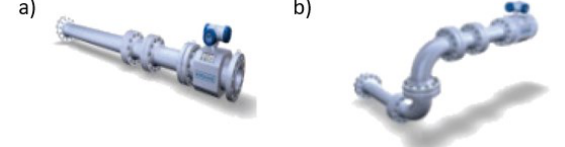
Fig. 3 Piping configurations for flow disturbances [3]: a) straight pipe (reference conditions), b) double elbow with a half-moon plate (OIML d+).